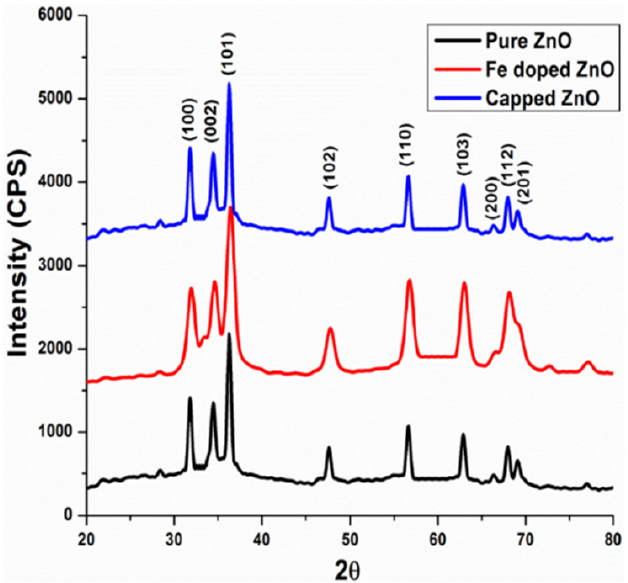
Figure 17. XRD patterns of various ZnO-based nanomaterials. Reprinted/adapted with permission from Ref. [192]. Copyright© 2022 , Elsevier B.V.